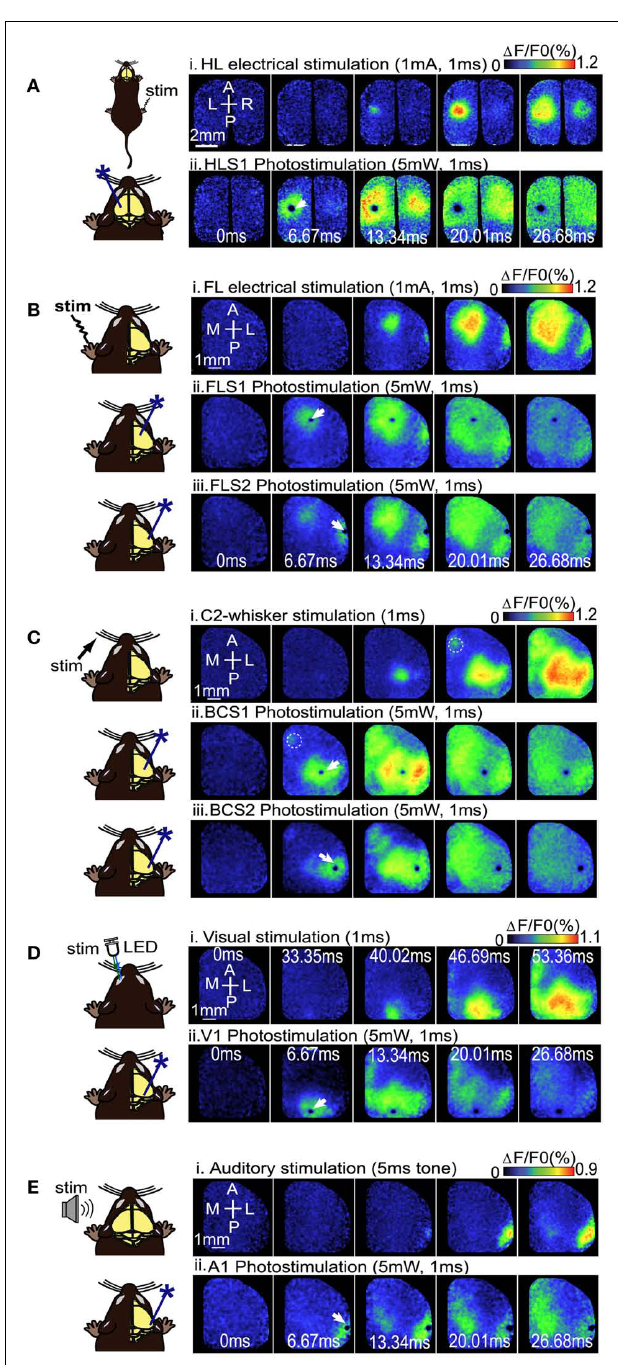
FIGURE 2 |Voltage sensitive dye imaging maps to compare sensory stimulation to local photostimulation. (A) Example ofVSD response in a bilateral craniotomy preparation after electrical stimulation of the right hindlimb (i) , or direct photostimulation of the left HLS1 (ii) . (B) Example of VSD responses in a unilateral craniotomy preparation during electrical stimulation of the contralateral (left), FL (i) , direct photostimulation of FLS1 (ii) , and direct photostimulation of FLS2 (iii) . (C) Example ofVSD responses in a unilateral craniotomy preparation during piezoelectric stimulation of a single whisker [C2; (i) ], direct photostimulation of BCS1 (ii) , and direct (Continued)